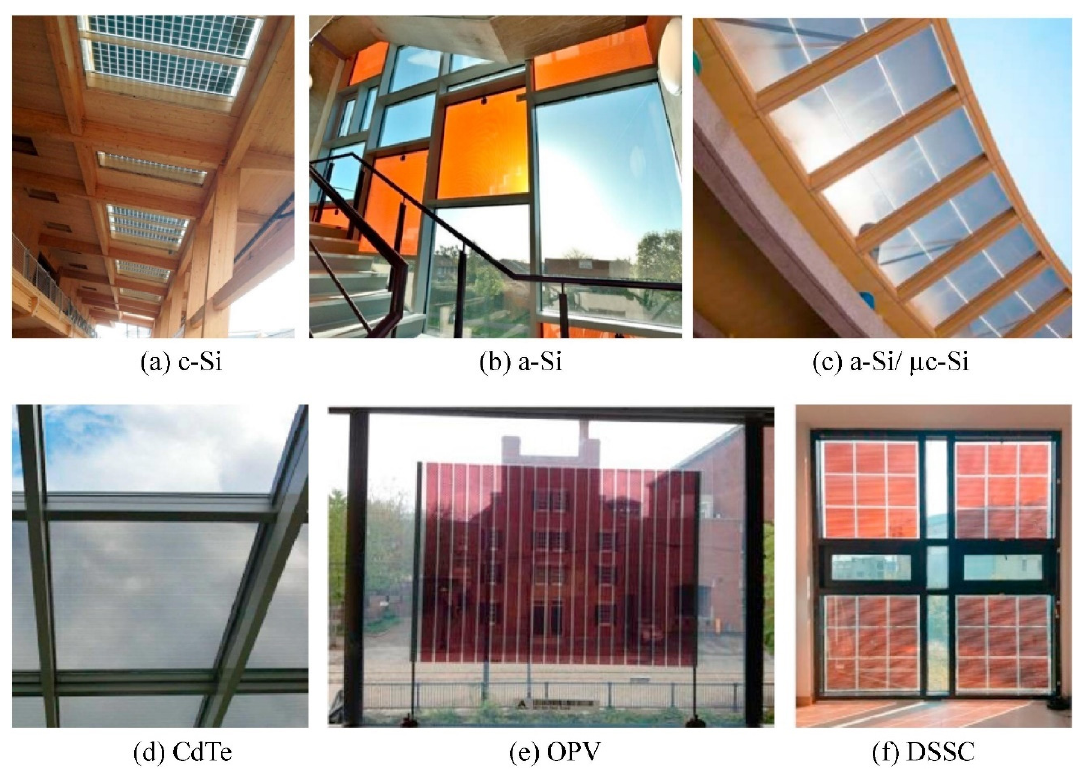
ff erent types of PV cell materials Figure 2. Window integrated with different types of PV cell materials [93]. Figure 2. Window integrated with di Figure 2. Window integrated with different types of PV cell materials [93].